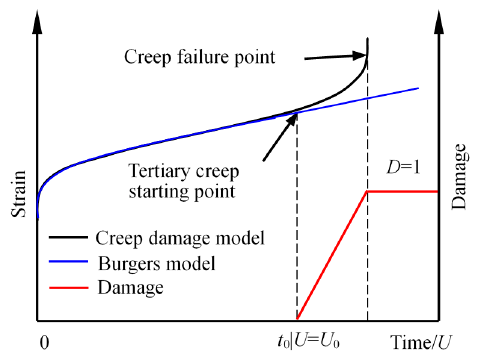
Figure 10. Rock creep damage model and Burgers model.